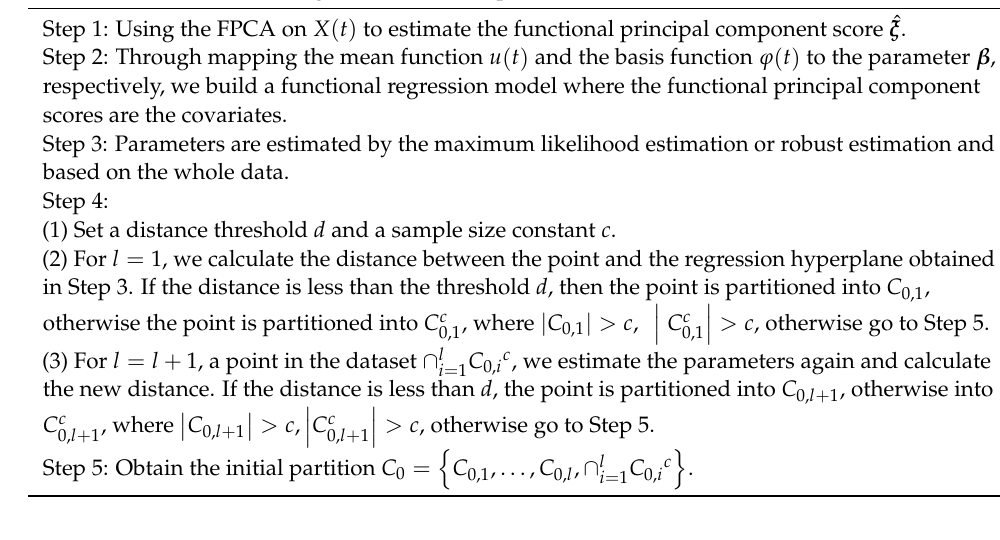
Algorithm 1 An iterative algorithm for initial